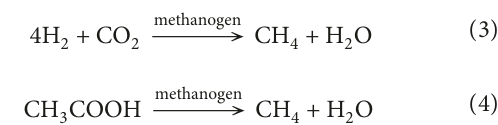
Figure 6: Changes in CO 2 concentration with different iron sources. ( ∗ , Control; □ , 4000mg 24000mg · kg − 1 ; ○ , 32000mg · kg − 1 ; ☆ , 40000mg · kg − 1 ). (a) Fe 0 . (b) Fe 2 O 3 . (c) FeC 6 H 5 O 7 . (d) Fe 2 (SO 4 ) 3